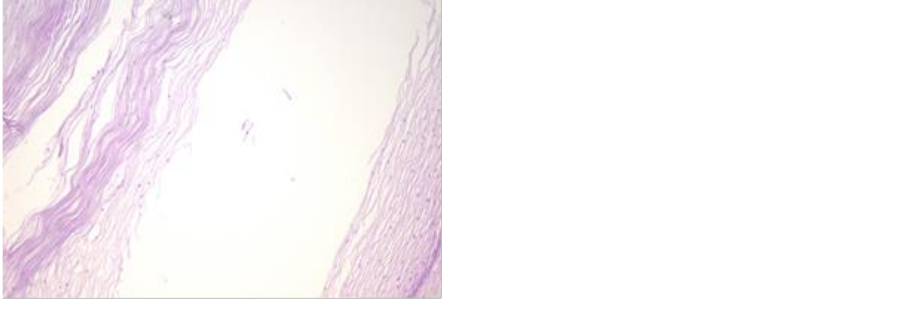
Figure 4. Cyst is lined by a stratified epithelium that resembles a squamous epithelium, similar in appearance to the endo-exocervical junctional area (HE staining, 10 × ).